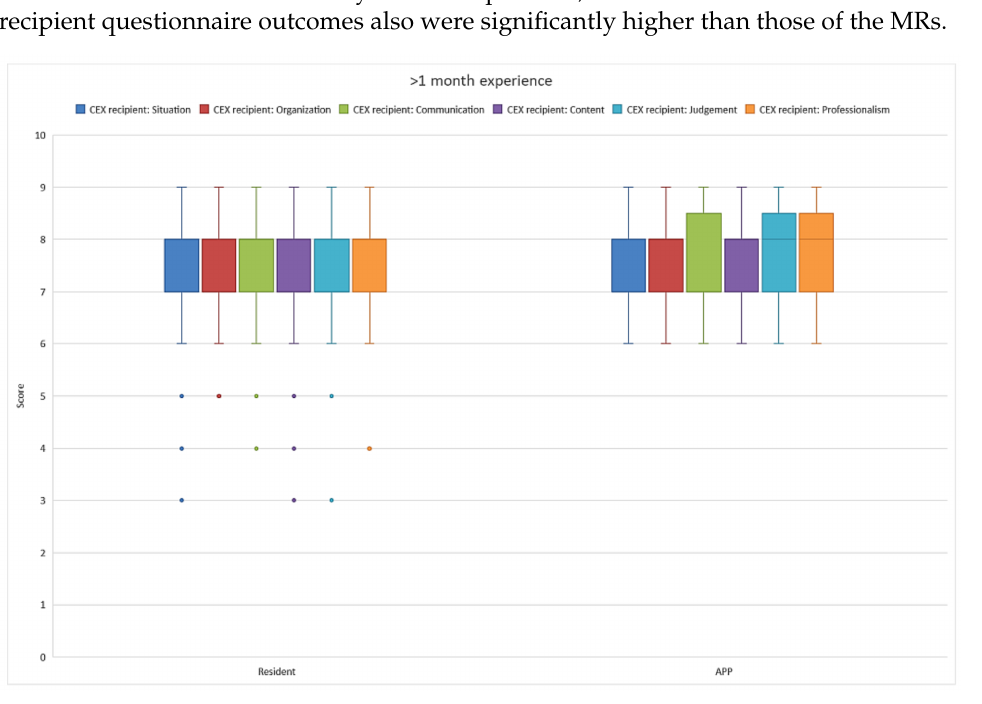
Figure 1. The handoff CEX recipient scores of MRs and APPs with more than 1 month experience.